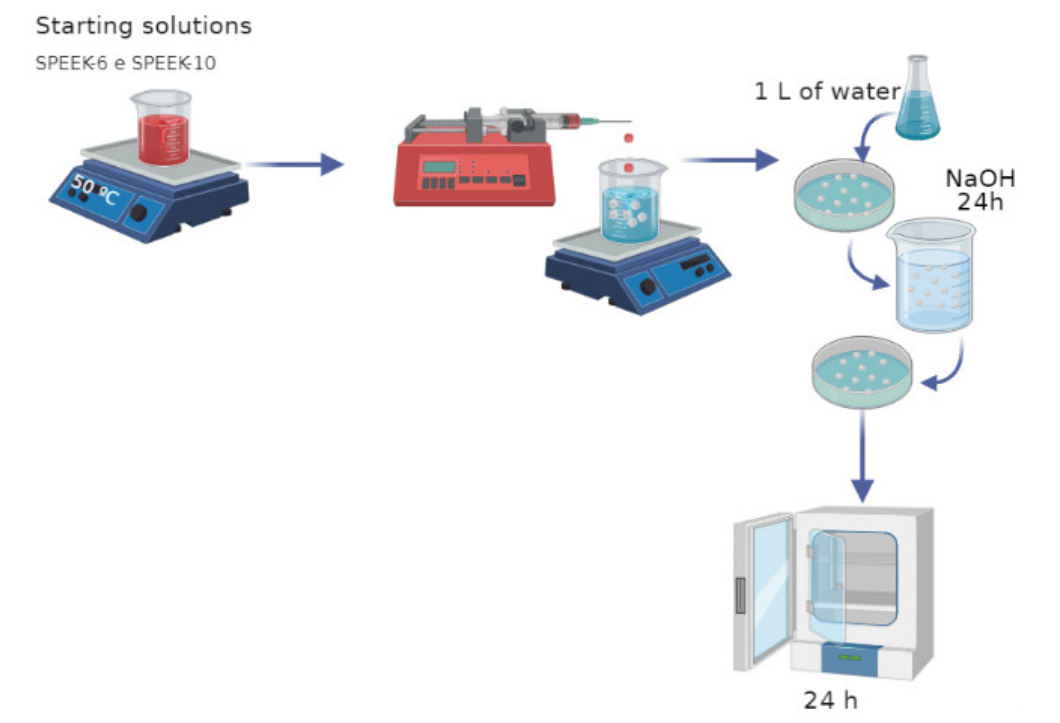
Figure 2. Method of obtaining SPEEK spheres.